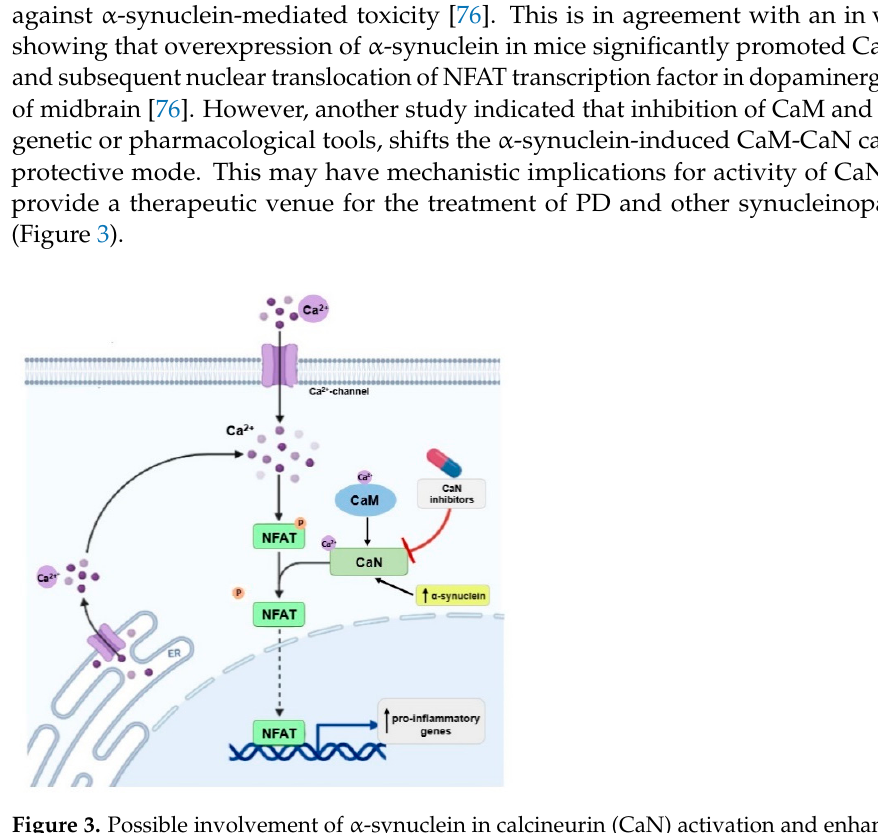
Figure 3. Possible involvement of α -synuclein in calcineurin (CaN) activation and enhanced expres- sion of pro-inflammatory genes.